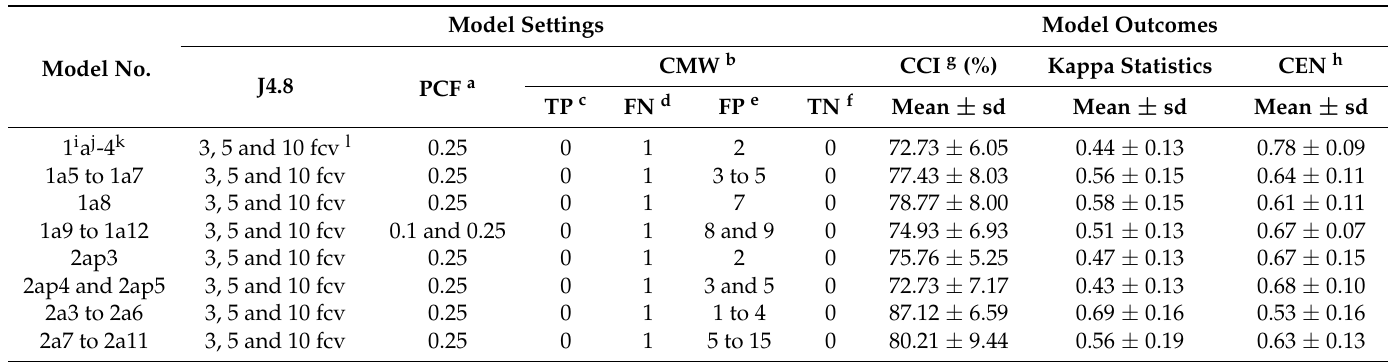
Mean and standard deviations of CCI, Kappa statistics and CEN were derived from k-fold cross validation. a PCF = Pruning confidence factor; b CMW = Cost Matrix Weights; c Fecal coliform regulation: 1 for recreational and 2 for agriculture; j Kind of database: ap = absence/presence, a = abundance; k Number of model with different value of PCF; l fcv = folds cross